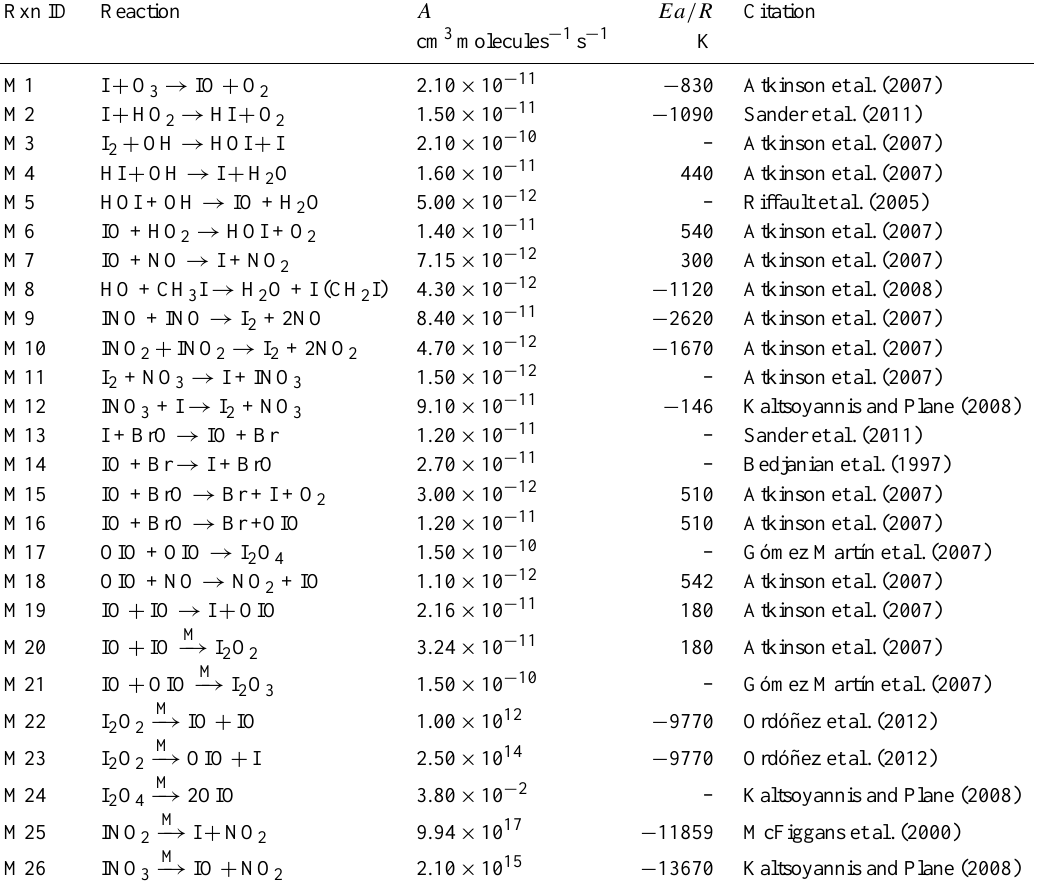
Table 3. Bimolecular and unimolecular iodine reactions. These are given in the Arrhenius form with the rate equal to A · exp ( Ea values are represented by a dash and these set to zero in the model, reducing the exponent to 1. The bimolecular reactions with an M in them represent termolecular reactions where the pressure dependence is not known or are unimolecular decomposition reactions. Reactions included, but not in IUPAC/JPL, are discussed further in Sect.